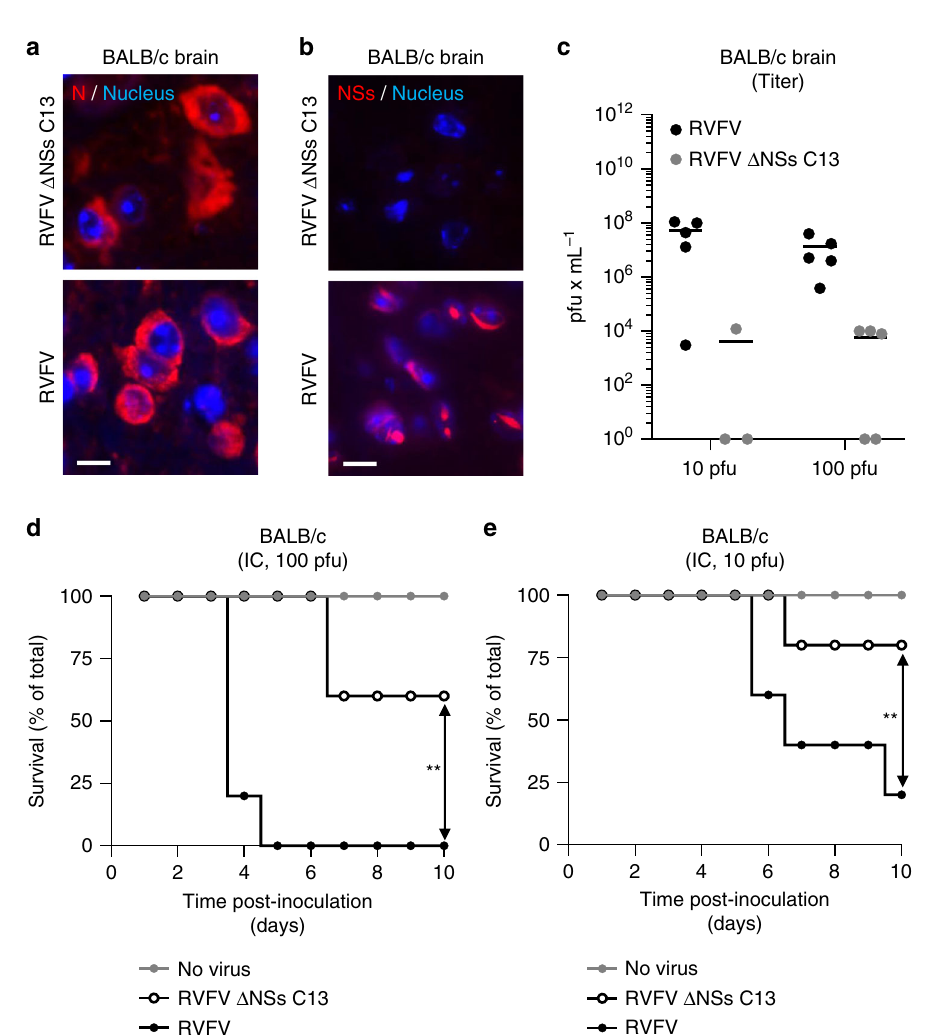
Fig. 10 Expression of NSs in the brain is responsible for animal death. a – e BALB/c mice were inoculated by intracranial injection with 10 and 100 pfu of RVFV and RVFV Δ NSs C13. a , b Brain tissues from animals infected with 100 pfu were stained with anti-N and anti-NSs Abs and visualized with a wide- fi eld scanner. Nuclei appear in blue and the proteins N a and NSs b in red. Experiments were repeated independently thrice with similar results. Scale bars, 10 µ m. c Brain from mice inoculated with 10 and 100 pfu of viruses were assessed for infectious particles by plaque-forming assay. Points represent titers of individual animals ( n = 5 with the exception of the injection with 10 pfu of RVFV Δ NSs C13, n = 3). Center line, mean. pfu, plaque-forming units. Groups of fi ve 9-week-old BALB/c male mice were inoculated with 100 d and 10 e pfu of viruses and survival of animals was monitored over 10 days. Simple linear regression tests were applied to assess the signi fi cance of differences observed between RVFV and RVFV Δ NSs C13. ** p = 0.0015 d and 0.0029 e